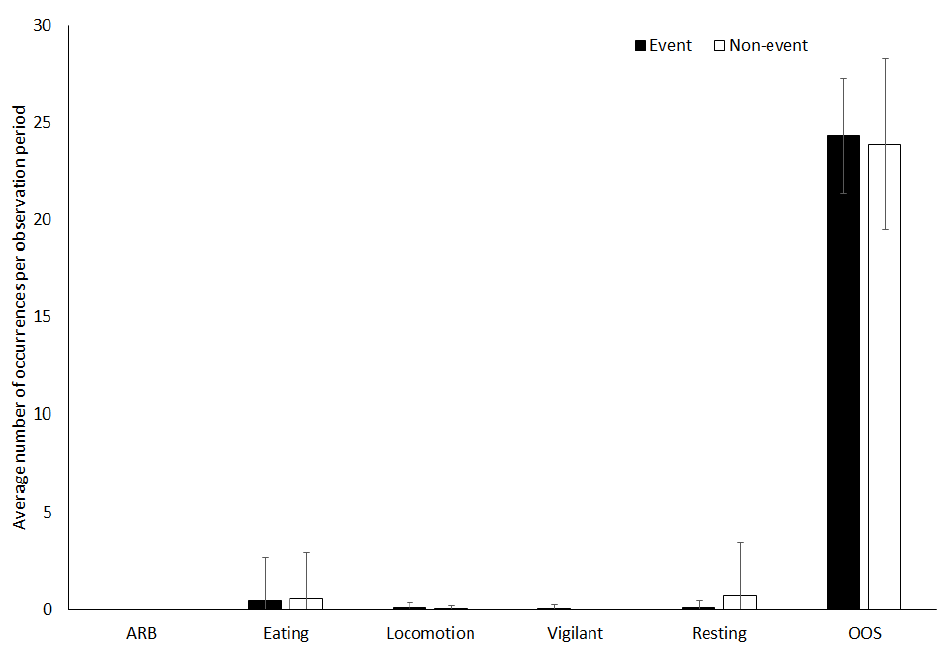
Figure 4. Activity budget data from 16:00 to 20:00 for five vicunas (average number of occurrences of each behaviour within the group per observation period ± standard deviation) on event nights and non-event nights at Knowsley Safari. ARB: abnormal repetitive behaviour, OOS: out of sight of the observer.